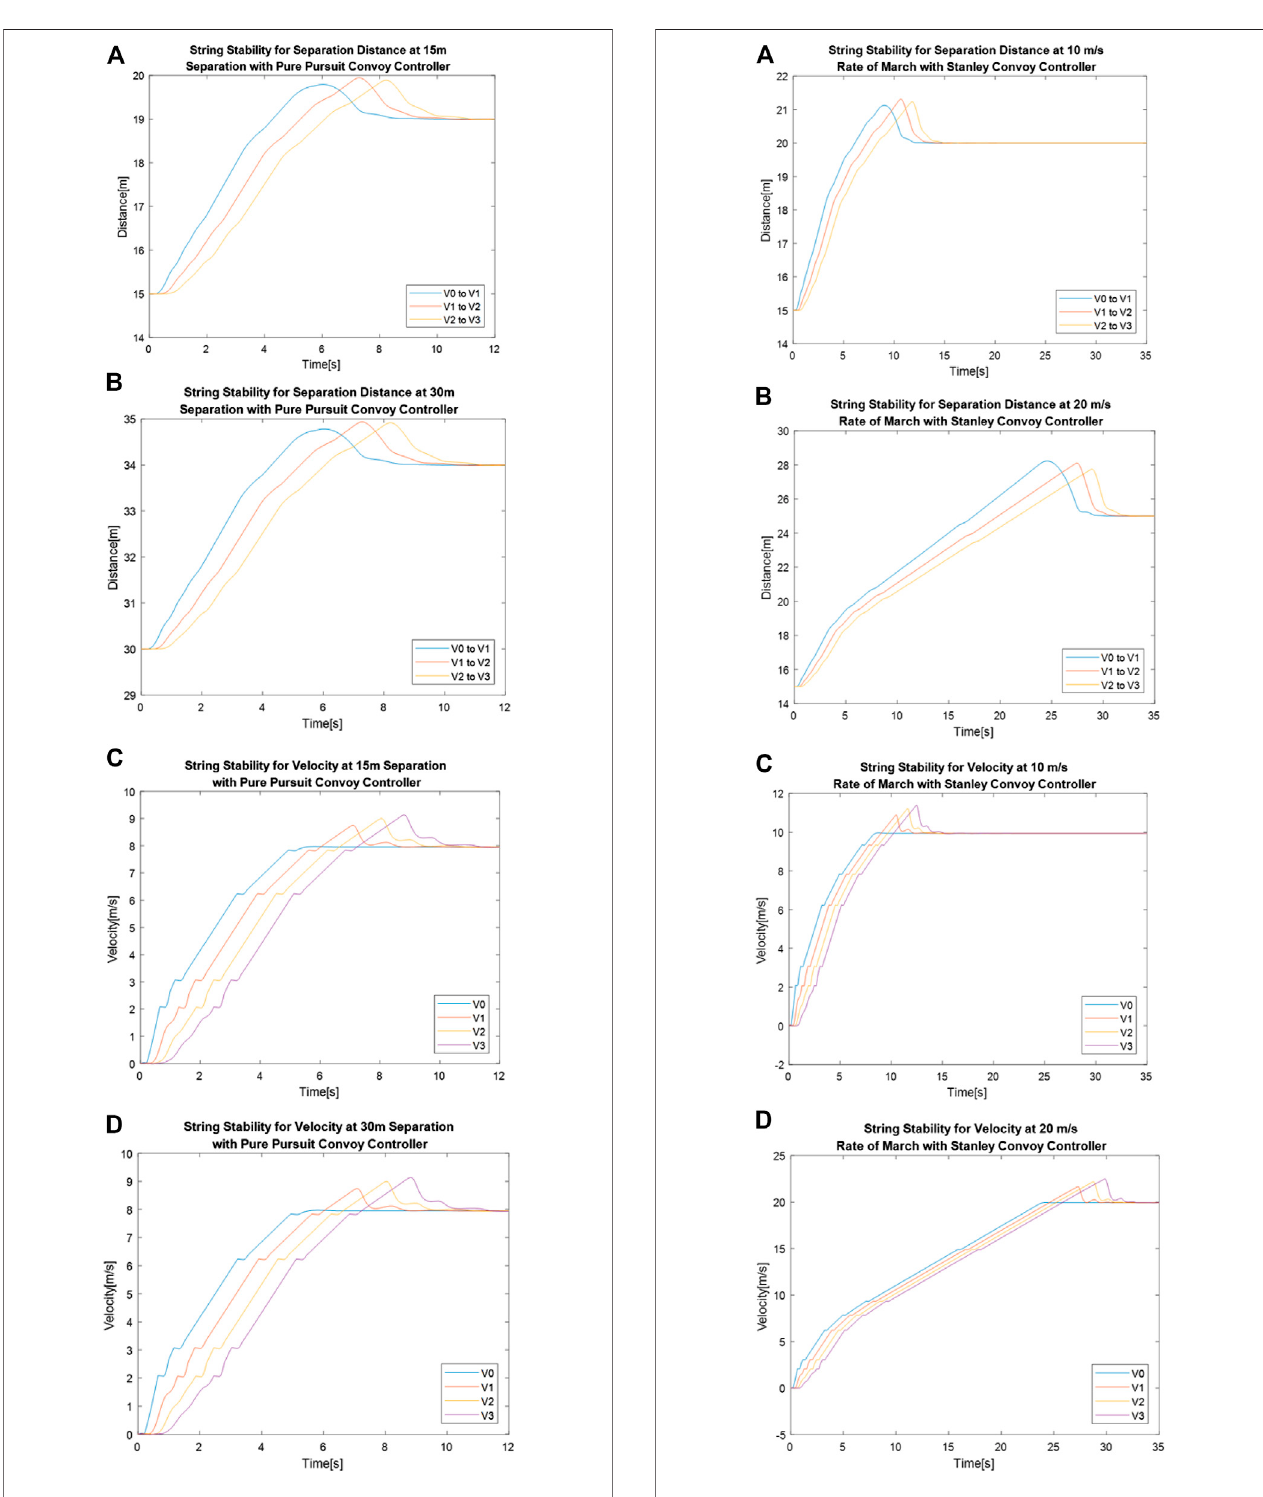
FIGURE 9 | Stanley convoy controller performance for separation distance between vehicles with a rate of march of (A) 10 m/s and (B) 20 m/s and velocity of vehicles over time with a gap distance of (C) 10 m/s and (D) 20 m/s.